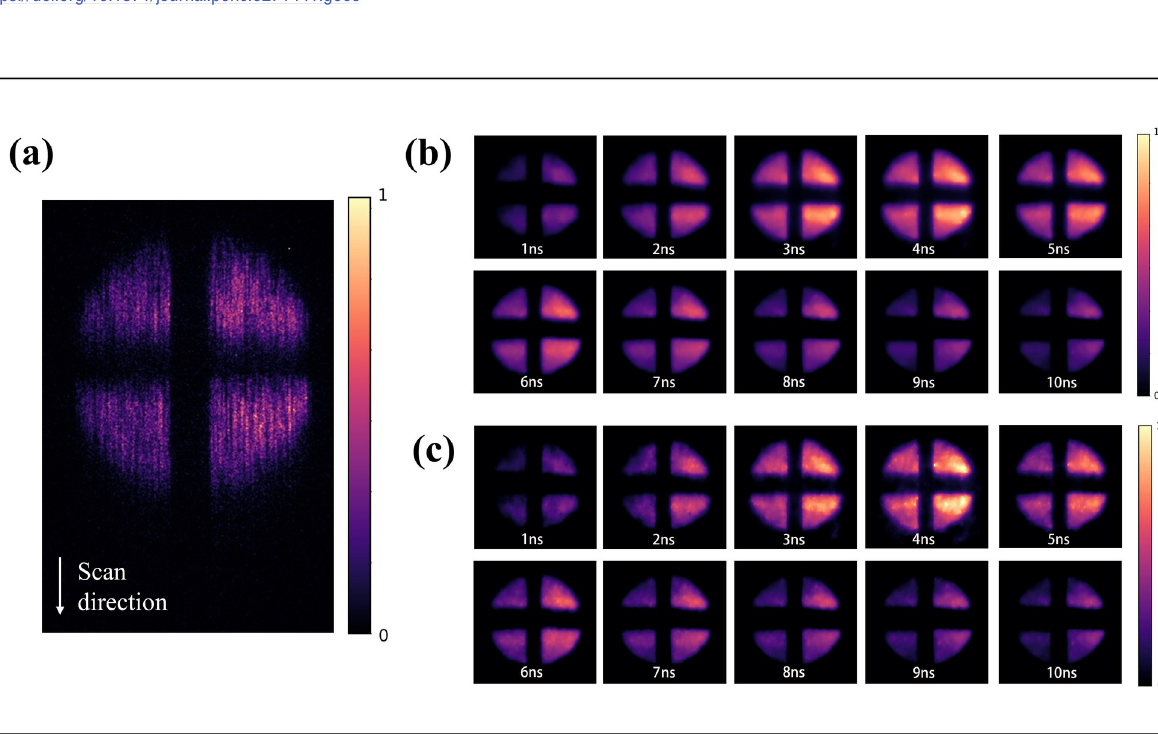
PLOS ONE | https://doi.org/10.1371/journal.pone.0271441 August 12, 2022 10 /